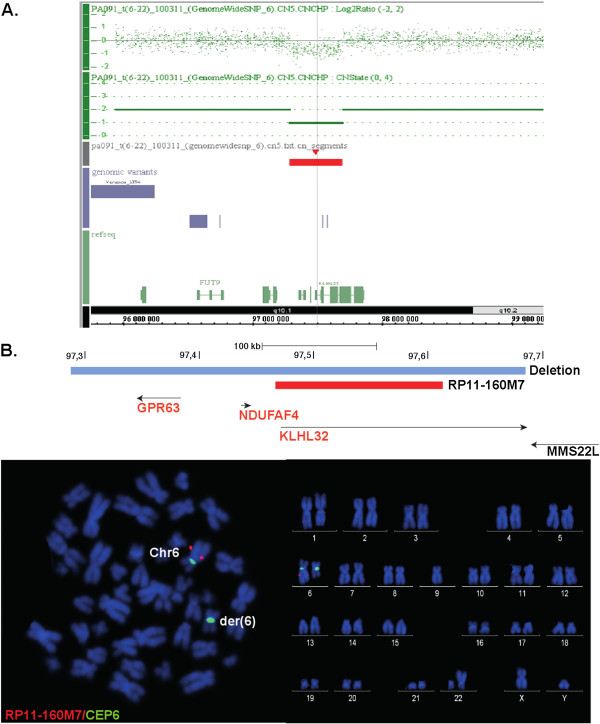
The 400 kb deletion carried by the proband. The deletion is mapped by SNP 6 array analysis and FISH hybridization on DNA and metaphase chromosomes, respectively. A. SNP 6 array data over the 6q-region showing the heterozygous deletion B. FISH using a BAC probe within the deletion hybridizes to the normal chromosome 6 but not to the chromosome 6 derivative.